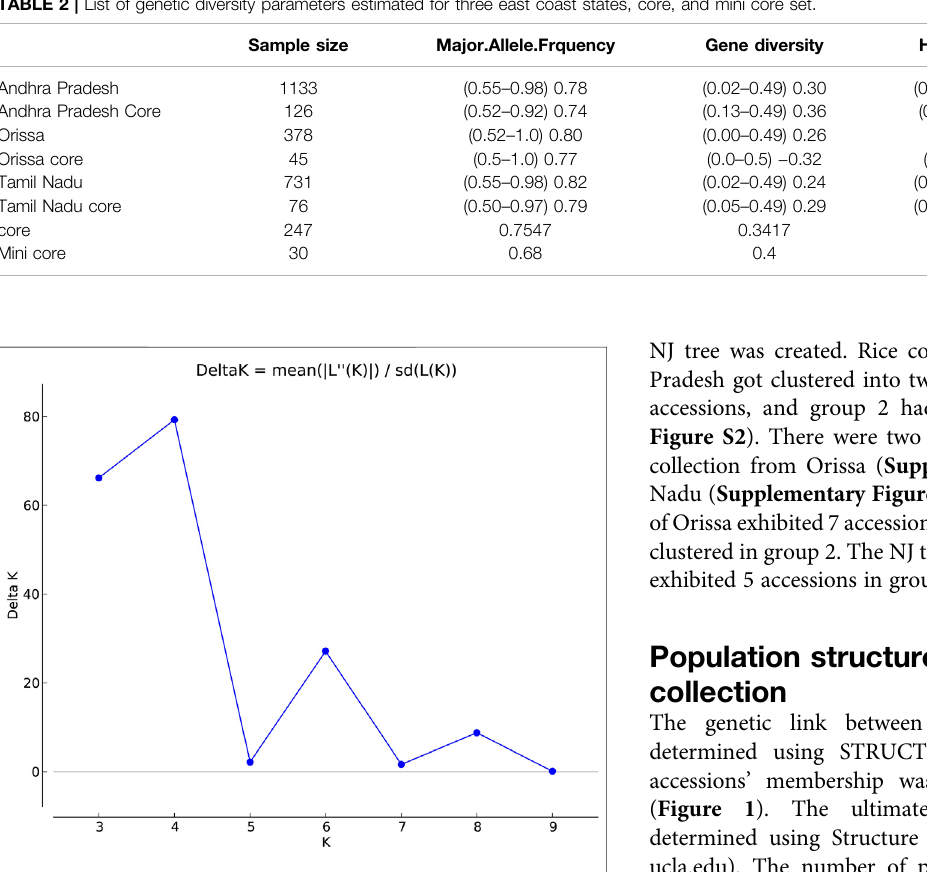
Frontiers in Genetics |